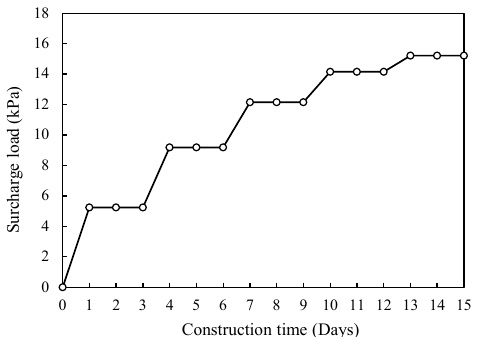
Figure 1. The surcharge load versus the construction time in the field and the numerical analysis.